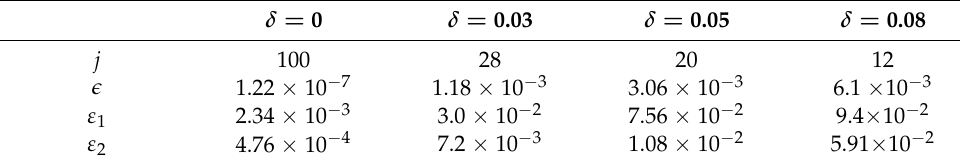
Figure 2. Numerical solution of unknown function σ 2 ( x ) for Example 1 with noisy input data. Table 1. The values of j , (cid:101) , ε 1 and ε 2 with various noisy level δ for Example